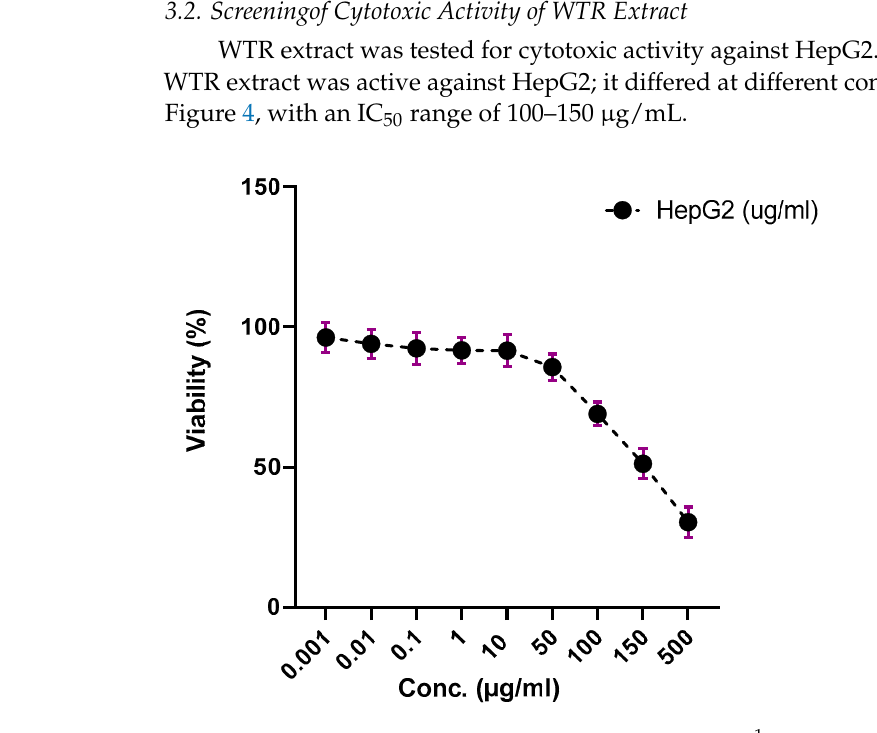
Figure 4. SRB (quick screening) curve of WTR (100 mg Kg − 1 ) against HepG2 cells .